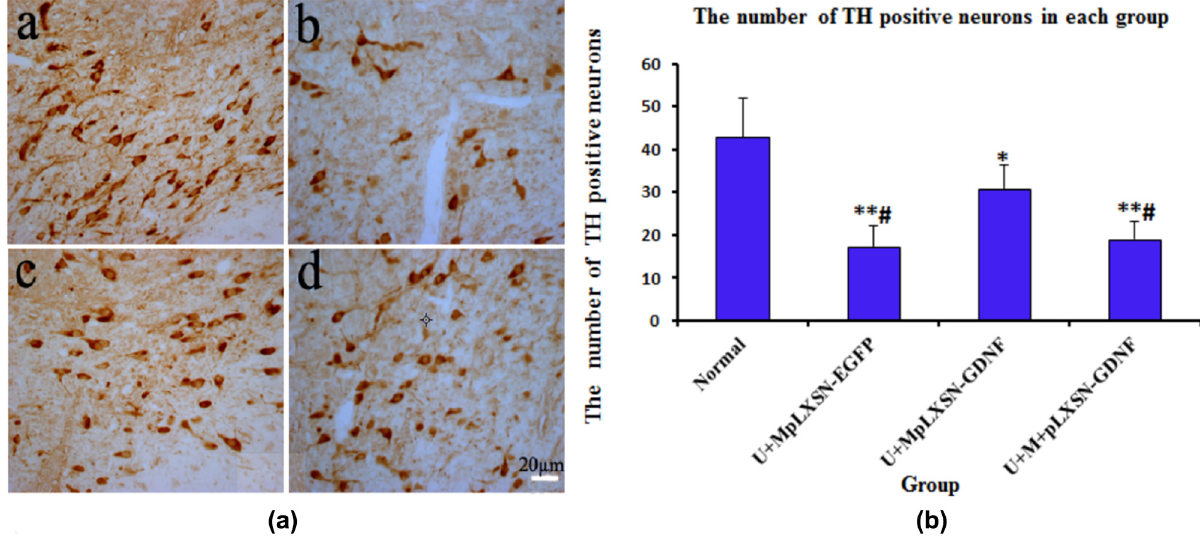
Figure 4: Quanti fi cation of the number of TH - positive neurons by immunohistochemistry analysis. ( a ) Determination of TH - positive neurons in each group; a: normal group; b: U + MpLXSN - EGFP group; c: U + MpLXSN - GDNF group; d: U + M + pLXSN - GDNF group; ( b ) analysis of TH - positive neurons in each group using ImagePro analysis software; compared with the normal group, * P < 0.05, ** P < 0.01; compared with the U + MpLXSN - EGFP group and U + MpLXSN - GDNF group, # P < 0.05.